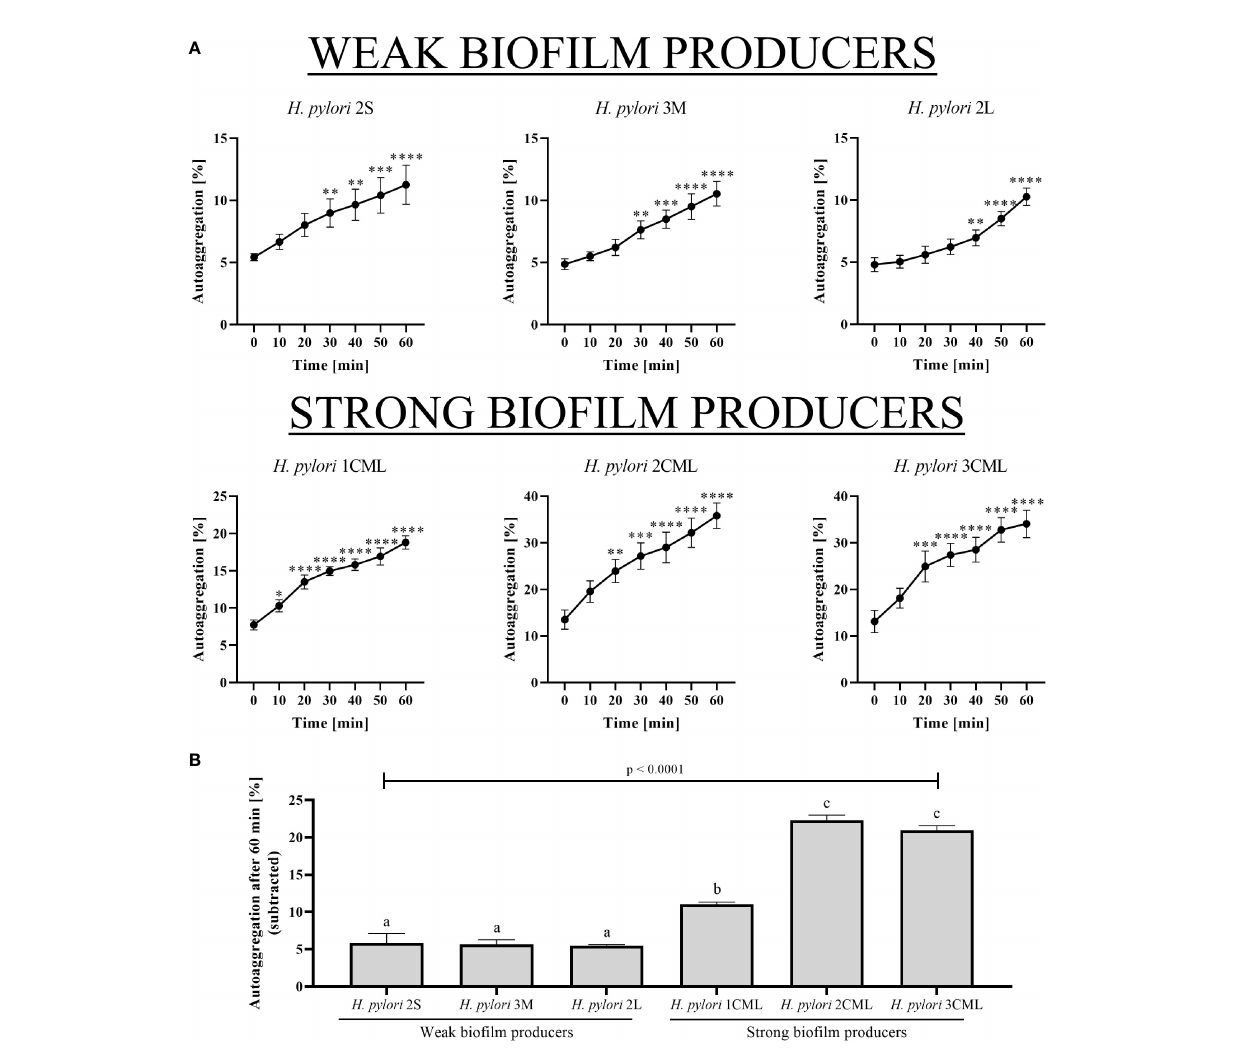
FIGURE 5 | The time-dependent autoaggregation capacity of six selected H. pylori strains (A) and the fi nal autoaggregation rate obtained after a 1-h incubation (B) . The analysis was performed by observing the rate of coverage of the microscopy observation fi eld in the obtained photos. The autoaggregation rate after 1 h was calculated by subtracting the initial autoaggregation value in the sample (T 0 ). In the fi gure (A) , p-values represented by *, **, ***, and **** are equal to < 0.05, < 0.01, < 0.001, and < 0.0001, respectively. In the fi gure (B) , columns with the same subscript letters (a, b, c) are not signi fi cantly different from each other (p > 0.05). The tests was performed in three biological replications (n =